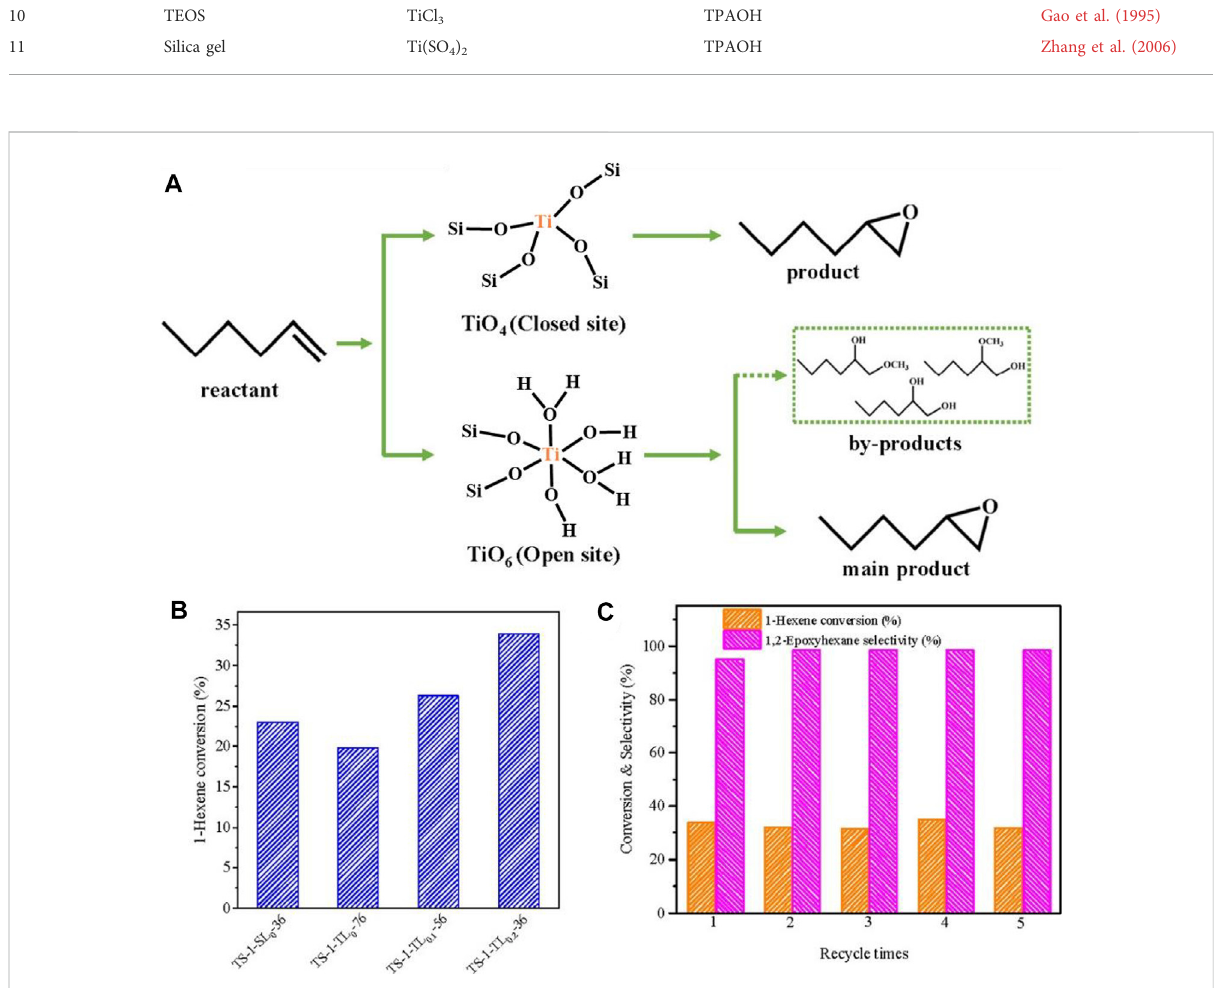
FIGURE 2 (A) Epoxidation routes directed by TiO 4 (closed sites) and TiO 6 (open sites) species in the TS-1 zeolites; (B) 1-Hexene conversion over the different TS-1 zeolites; (C) 1-Hexene conversion and product selectivity of the recycle test using TS-1-TL0.2-36. Reprinted with permission from Wang et al. (2021). Copyright 2021